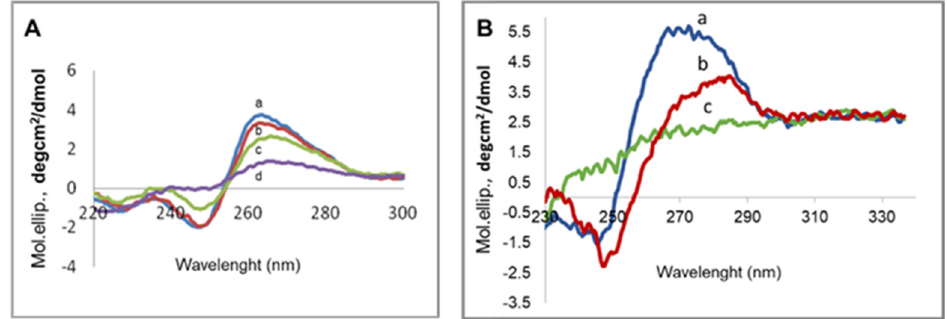
Figure 7. Circular dichroism of LX. ( A ) (a, blue) mRNA. mRNA complexed with 2 / DOPE (lipid molar ratio 2/1) liposomes at mRNA/L ratio 1/0.5 (b, red), 1/1 (c, green) and 1/2 (d, purple). ( B ) (a, blue) pDNA. pDNA complexed with 2 / DOPE (lipid molar ratio 2/1) liposomes at DNA/L ratio 1/1.5 (b, red)1/2, (c, green).